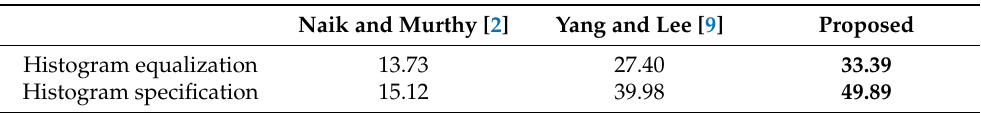
Table 1. Mean saturation of the images in Figure 6, where the maximum value in each row is indicated in